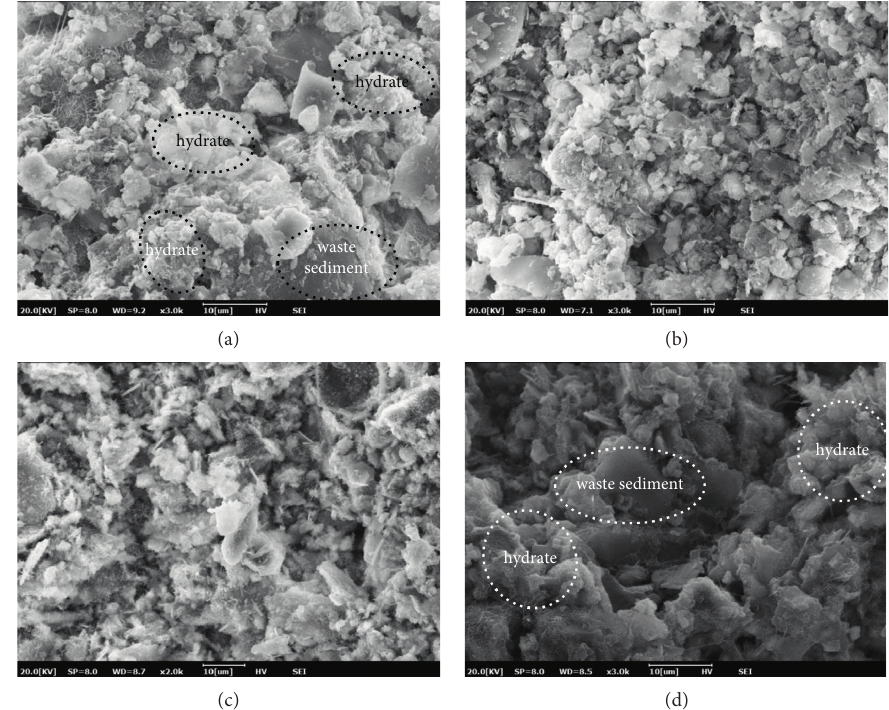
Figure 13: SEM images of hardened waste sediment-based grouting material after curing for 28 days: (a) S3; (b) S9; (c) S12; and (d) S14.